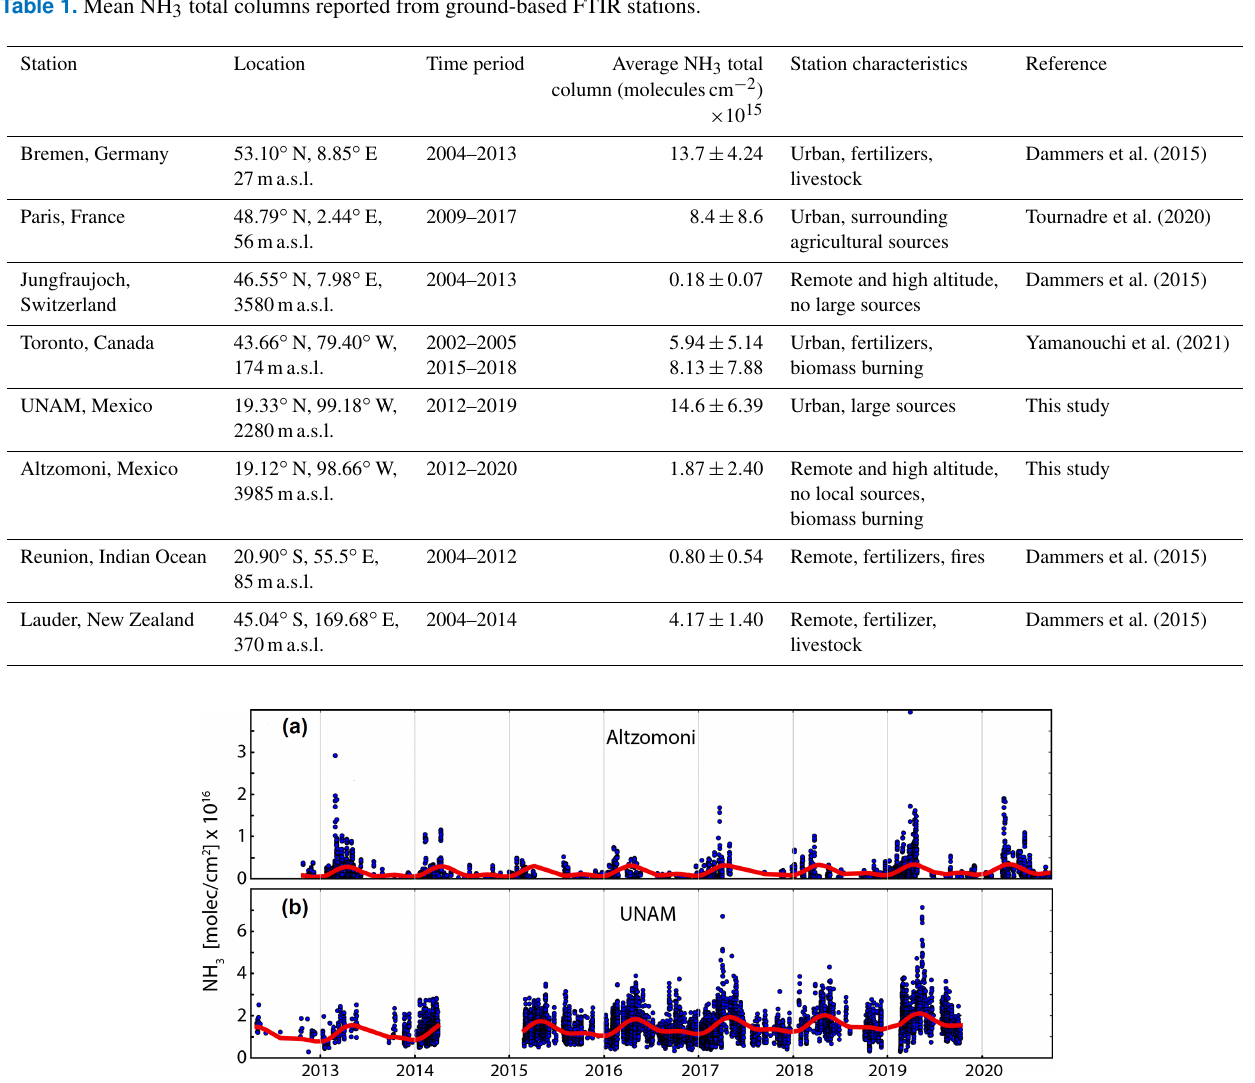
Table 1. Mean NH 3 total columns reported from ground-based FTIR stations.